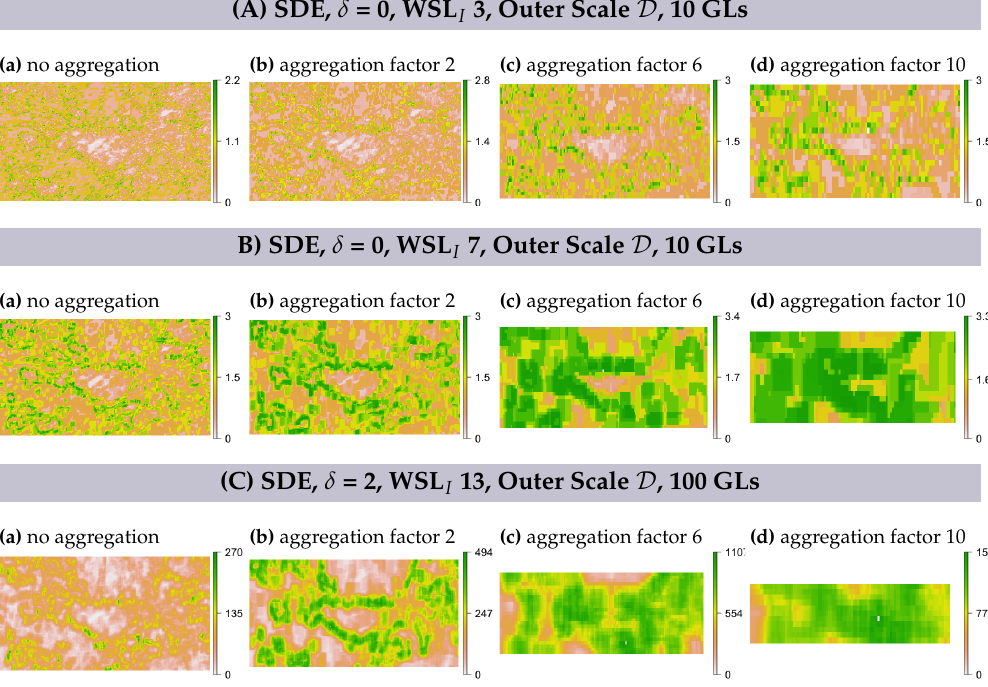
Figure 10. Structural diversity entropy (SDE), quantified wit δ ∈ { 0,2 } , the outer scale is D in all cases. Minimum values displayed are set to